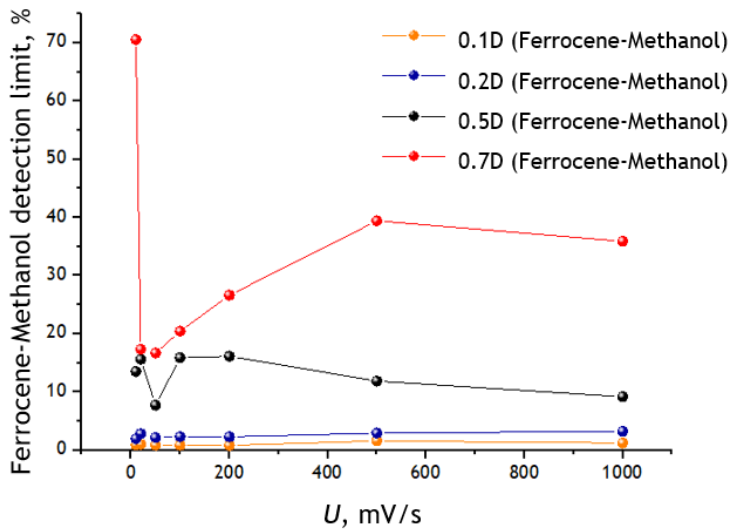
Figure 22. Dependence of the theoretical detection limit of a low molecular weight substance on the sweep rate for pairs of substances with different diffusion coefficient